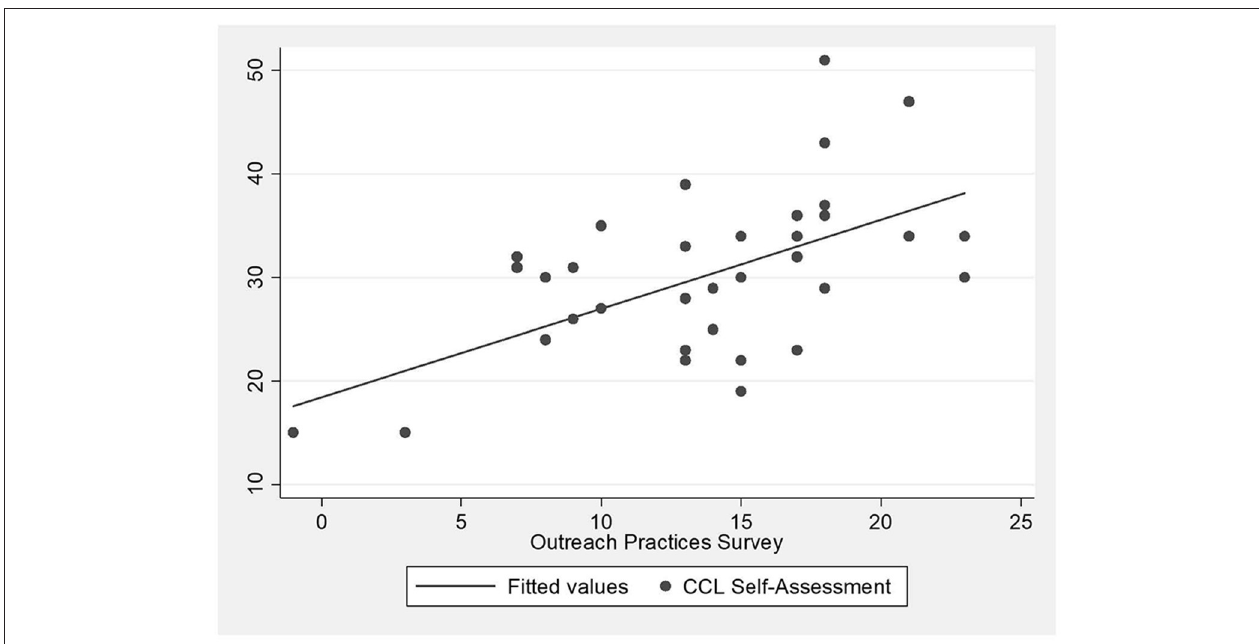
FIGURE 2 | Comparison of scores of clinical-community linkage self-assessment survey and outreach practices survey.